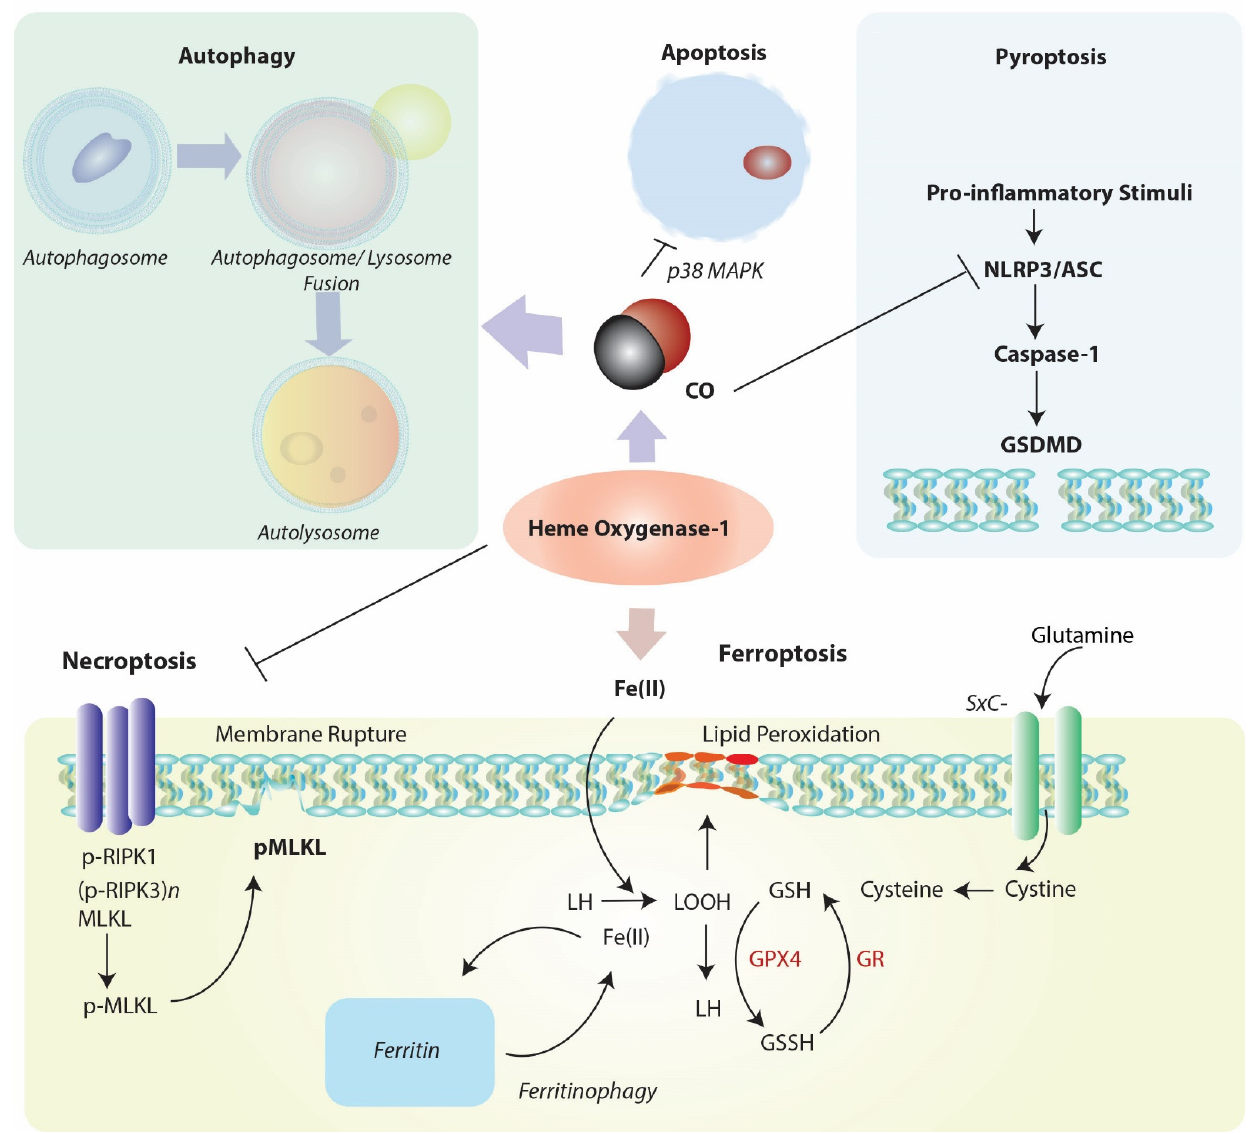
Figure 3. Positioning of HO-1 in relation to cellular homeostatic, apoptotic, and regulated cell death (RCD) programs. Heme oxygenase-1 and/or its reaction product CO can modulate the cellular autophagy program, which degrades cytosolic proteins and organelles, and is itself implicated in cellular survival/protection. HO-1 via its reaction product CO has been identified as a cellular antiapoptotic mediator via regulation of p38 MAPK and other factors. Induction of HO-1 via either heme clearance and/or CO production may act as a mediator of inflammatory RCD programs. Among these, HO-1-derived CO may inhibit NLRP3-ASC-mediated caspase-1 activation, which in term regulate gasdermin-D (GSDMD)-initiated pyroptosis. HO-1 dependent heme clearance may play a protective role in regulating RIPK3/MLKL-dependent necroptosis. Finally, HO-1-derived iron may promote lipid peroxidation, leading to ferroptotic cell death which implicates HO-1 as a pro-death regulator in the context of iron overproduction. This pathway is counter-regulated by ferritin, which sequesters iron, and promoted by autophagy-dependent degradation of ferritin (ferritinophagy). Abbreviations: ASC: apoptosis-associated speck-like protein containing caspase-activation and recruitment doman [CARD]; GSDMD: gasdermin-D; GSH: glutathione (reduced form); GSSG: glutathione disulfide (oxidized form); GPX4: glutathione peroxidase-4; GR: glutathione reductase; LH: lipid (reduced form); LOOH: lipid hydroperoxide; MLKL: mixed-lineage kinase domain-like pseudokinase (p-, denotes phospho- form); NLRP3: nucleotide-binding domain, leucine-rich-containing family, pyrin domain-containing-3; RIPK1: receptor-interacting serine/threonine-protein kinase 1; RIPK3: receptor-interacting serine/threonine-protein kinase-3 (p-, denotes phospho- form); SXc-: cystine/glutamate transporter, System Xc-.